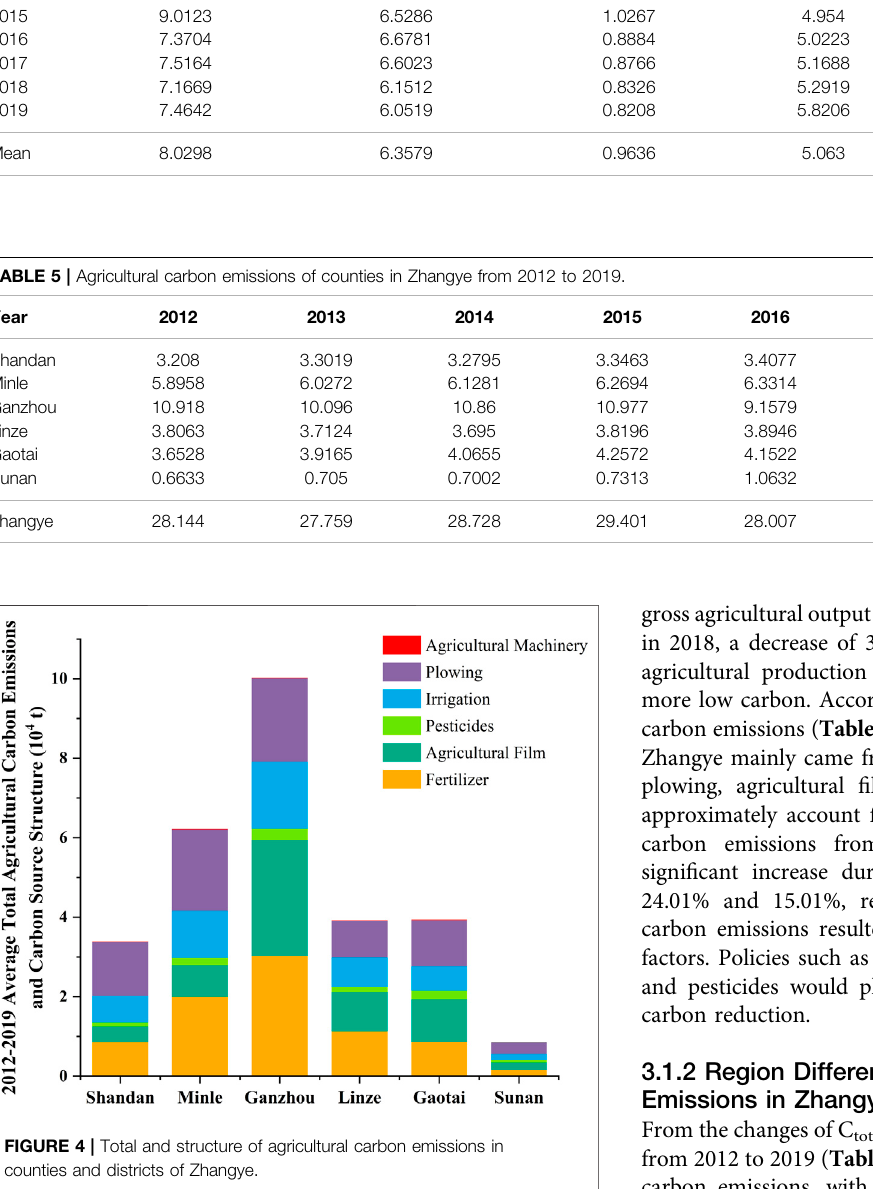
Frontiers in Environmental Science |